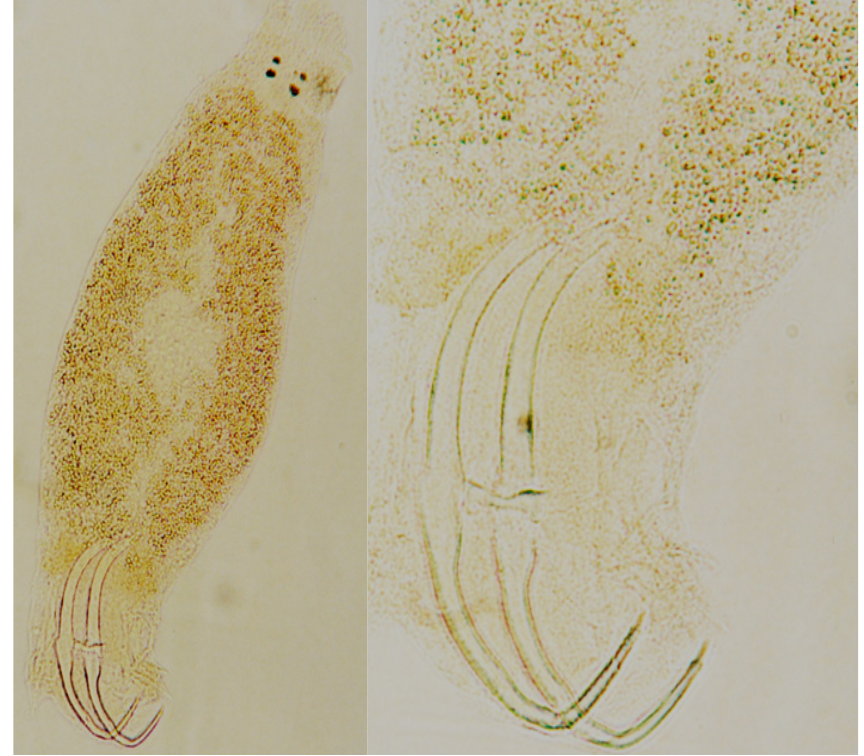
Fig. 2. D. anchoratu s total view and haptor